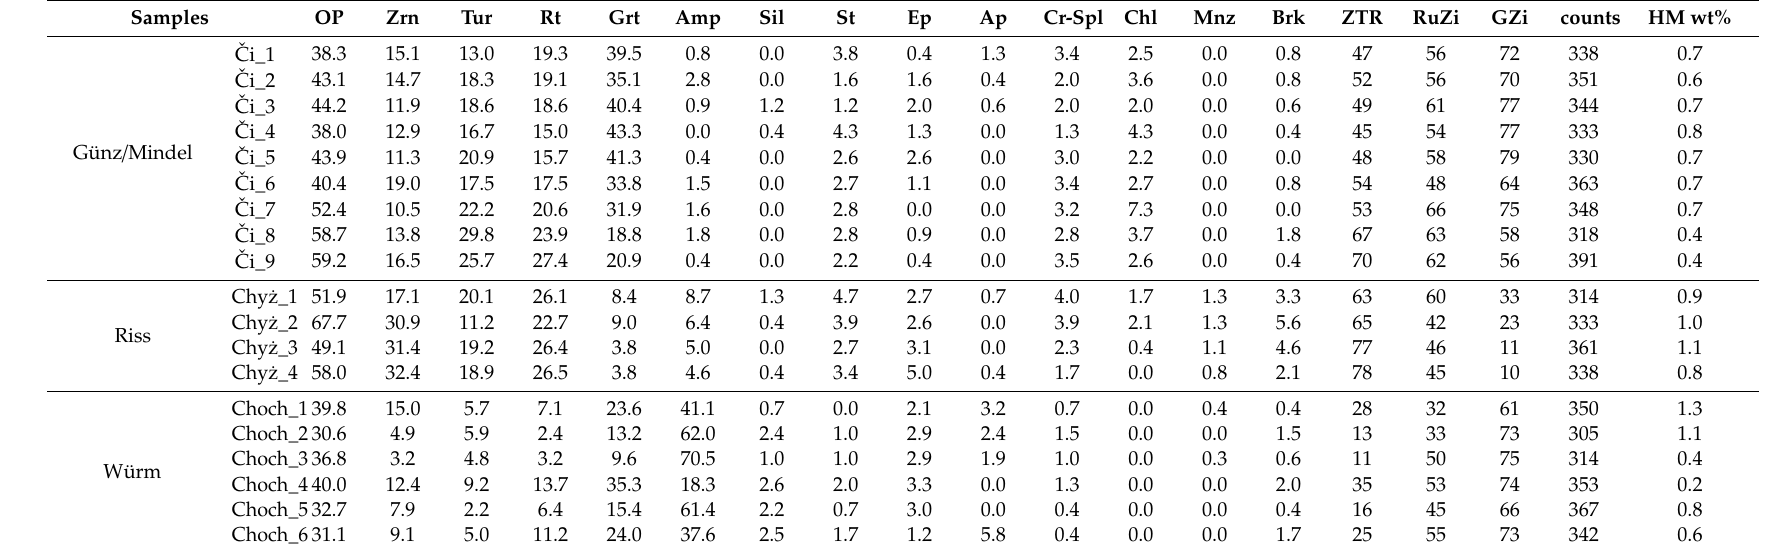
Table 2. Abundances of heavy minerals and provenance indices in the loess-like deposits of the Orava Basin.